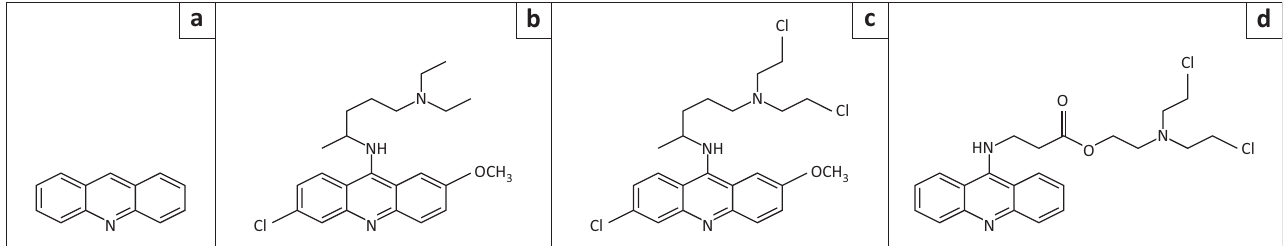
FIGURE 4: Members of the acridine family of compounds: (a) Structure of acridine; (b) Structure of acridine family member quinacrine; (c) Structure of acridine family member quinacrine mustard; (d) Structure of acridine family member S-303.